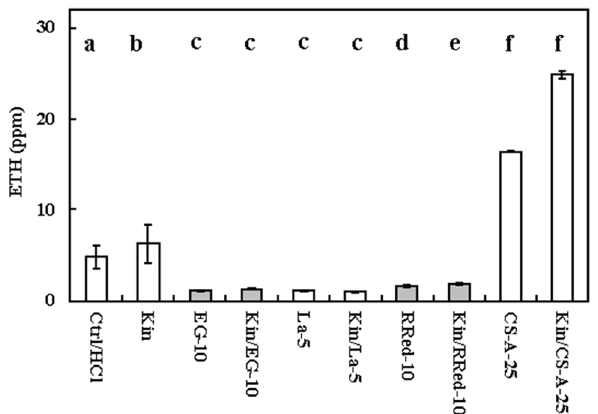
Figure 7. Ethylene amounts in the atmosphere of growing Vicia faba ssp. minor of control (Ctrl) seedlings and those treated with EGTA (ethylene glycol-bis(β-aminoethyl ether)-N,N,N ′ ,N ′ -tetraacetic acid, 10 μM, series EG–10), La 3+ (lanthanum, 50 μM, series La–5), (RRed (ruthenium red, 10 μM, series RRed-10) and cyclosporine A (25 μM, series CS-A–25) as well as kinetin (Kin) with EGTA (10 μM, series Kin/EG–10), Kin with La 3+ (5 μM, series Kin/La–5), Kin with 10 μM RRed (Kin/RRed–10); Kin with 25 μM CS-A (Kin/CS-A–25). Bars indicate ± SE of the results from three biological replicates. The means of the results with the same letter above the column are not significantly different at p ≤